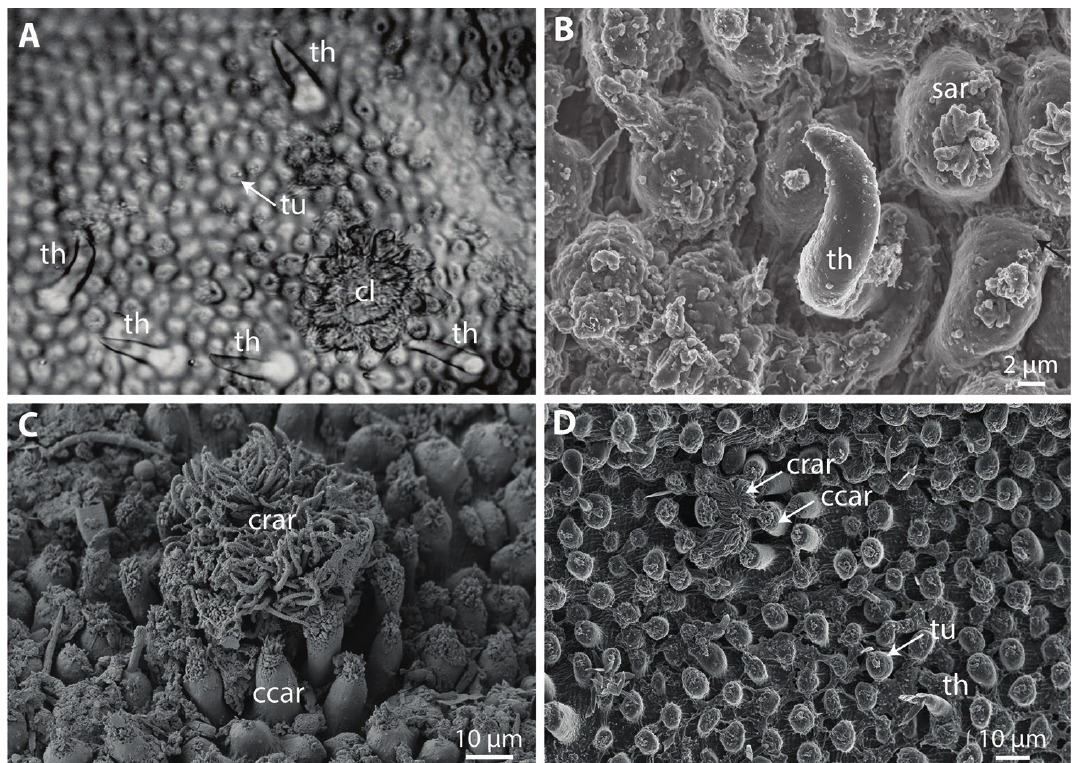
Figure 3. Chordodes colchis , male, cuticular structure. A. Cuticle of the ventral surface with simple, tubercle (tu), thorn (th) and crowned (cl) areoles. B. Magnification of twisted thorn surrounded by simple areoles (sar) and tubercle areoles. C. Cluster of crowned areoles (crar) with short filaments, surrounded by circumcluster areoles (ccar). D. Overview on the cuticle with all areolar types (for abbreviations see A–C). A by light microscopy (no scale taken), B–D by